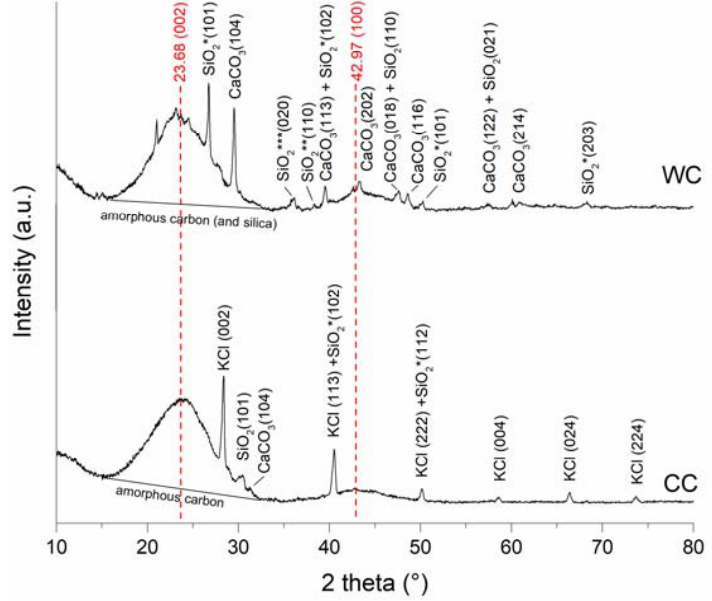
Figure 3. XRD diffraction pattern from wood ‐ chip (WC) and corn ‐ cob (CC) biochars. Surface functional moieties of BC and CC biochars and corresponding feedstock measured by FT ‐ IR in the mid ‐ infrared region are shown in Figure 4. It is clear that the FT ‐ IR spectra of both biochars pyrolyzed at 500 °C compared to the feedstock material showed a substantial decrease in (i) O ‐ H groups’ vibrations (3400 cm − 1 ) as a result of de ‐ hydration, and (ii) aliphatic C ‐ H stretch vibrations (2925 cm − 1 ) because of lignin demeth ‐ oxylation and demethylation during pyrolysis [20]. However, the aromatic ν (C=C) band at 1586 cm − 1 and C ‐ H bending aromatic CH out ‐ of ‐ plane deformation at 876, and 820 cm − 1 have significant intensities in both studied biochars (Figure 4). The biochars’ low ‐ intensity bands at 1050 and 1705 cm − 1 are associated with carbonyl and carboxylic groups C ‐ O and C=O stretching vibrations of undecomposed cellulosic and ligneous carbon [44]. The spec ‐ tral properties of biochar are often related to the mineral fraction of BC. The abundance of carbonate (CO 32 − ) is suggested by peaks at 820 cm − 1 and is in agreement with the presence of calcite in both the CC and WC biochars (Figure 3). In addition, the spectral region of 1140–1000 cm − 1 matches the Si ‐ O and Si ‐ O ‐ Si bonding, as indicated by EDX analysis (Si on the elemental map, Figures 1 and 2) and XRD (Figure 3) analyses.